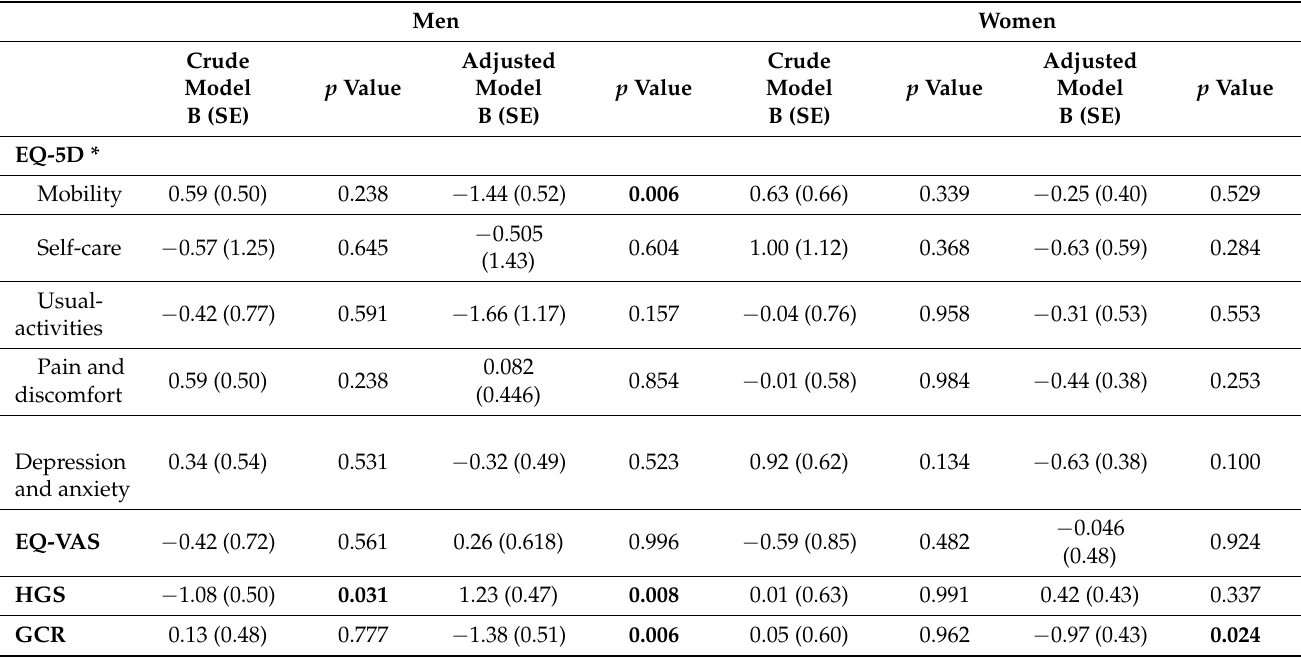
Table 4. Logistic regression of the association between ACTN3 R577X polymorphism (recessive model XX/(RR+RX) (rf)) and each dimension of EQ-5D, EQ-VAS, HGS, and